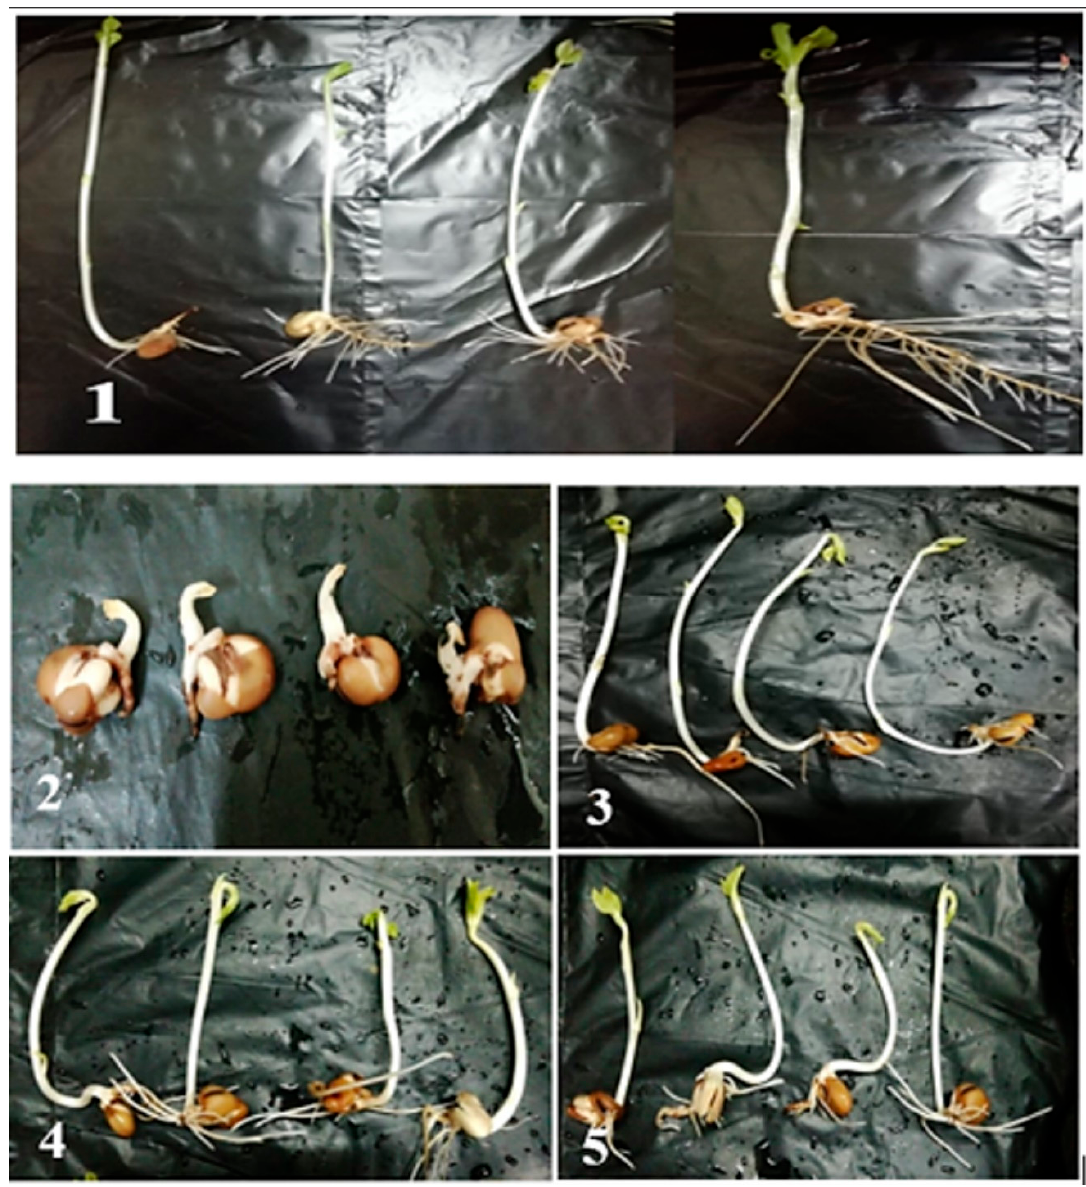
Figure 6. ( 1 ) Phytotoxicity study of textile wastewater on Vicia faba L. seeds using two fungal strains and their consortium. ( 1 ) Seeds after being treated with freshwater, ( 2 ) Seeds after being treated with textile effluent without fungal treatment: ( 3 ) Seeds after being treated with textile effluent degraded by a fungal consortium ( A. flavus with F. oxysporium A2*G2-1). ( 4 ) Seeds after being treated with textile effluent degraded by A. flavus ; A2 ( 5 ) Seeds after being treated with textile effluent degraded by F. oxysporium G2-1 .